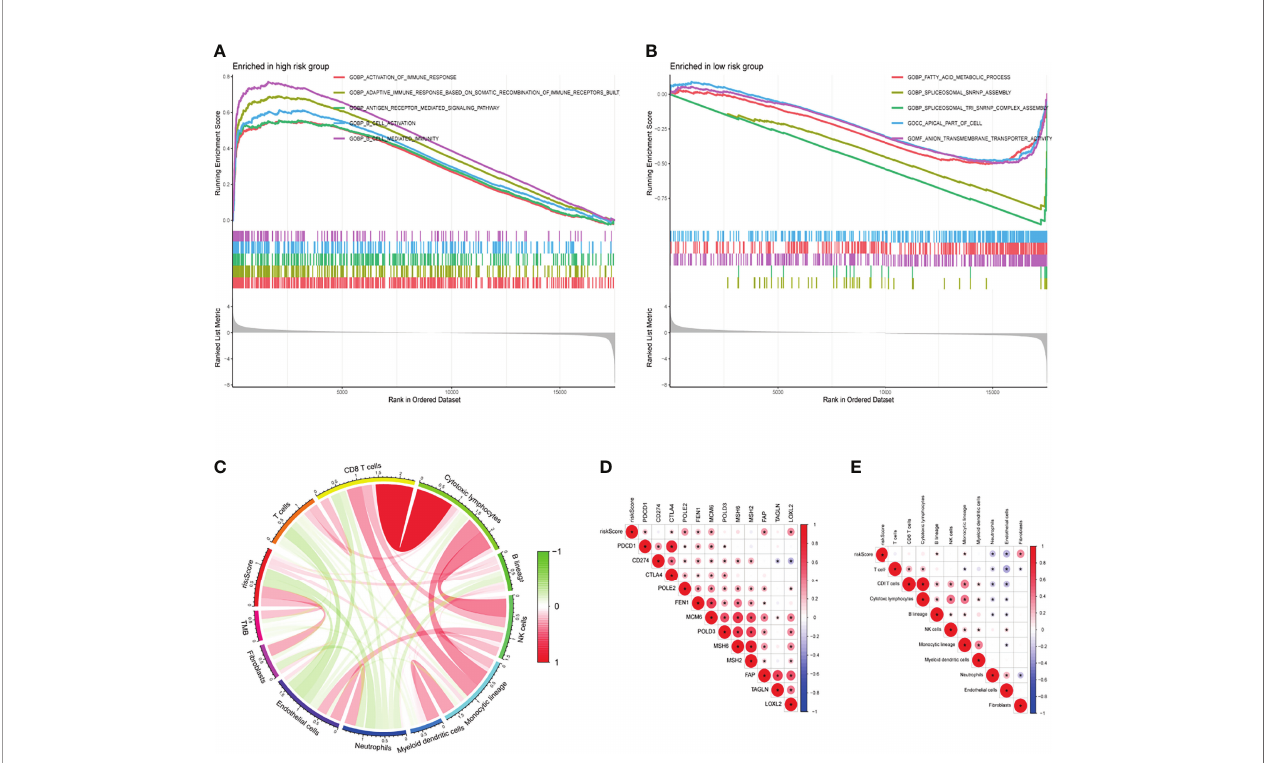
FIGURE 8 | GSEA and immune correlation analyses of the TME-related signature. (A, B) GO-BP analyses for high- and low-risk groups. (C) Correlation between the risk score for our signature, immune cell score via the MCP-counter algorithm, and TMB (Pearson method). (D) The relationship between the risk score and expression of representative genes for immune checkpoints, DNA replication, mismatch repair, and epithelial-mesenchymal transition (Pearson method). (E) The relationship between the risk score and tumor immune in fi ltrating cells (Pearson method). GSEA, gene set enrichment analysis; TME, tumor microenvironment; GO, gene ontology; BP, biological process; MCP-counter, microenvironment cell populations-counter; TMB, tumor mutation